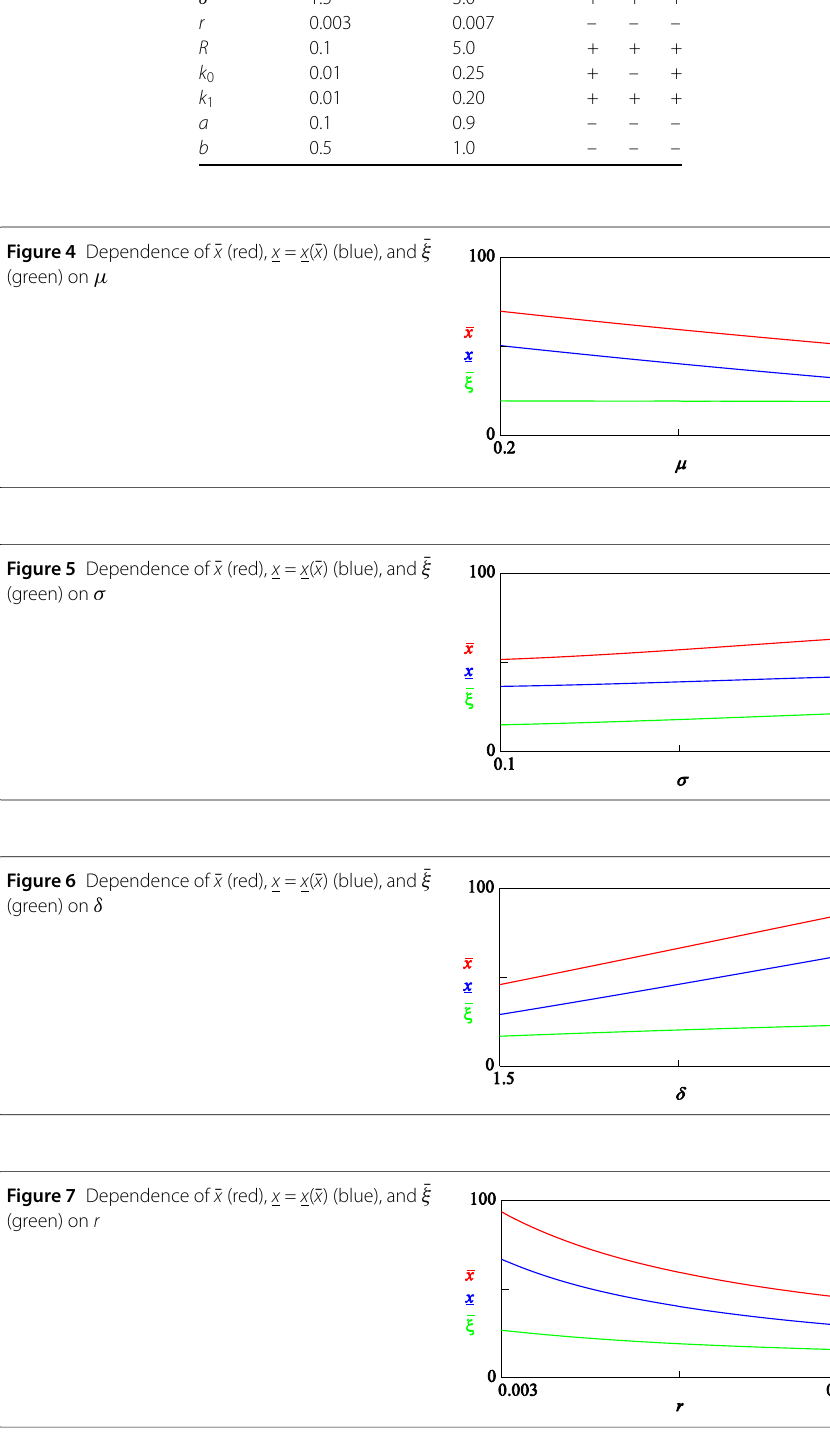
¯ ξ = ¯ x – x . ¯ ξ with respect to